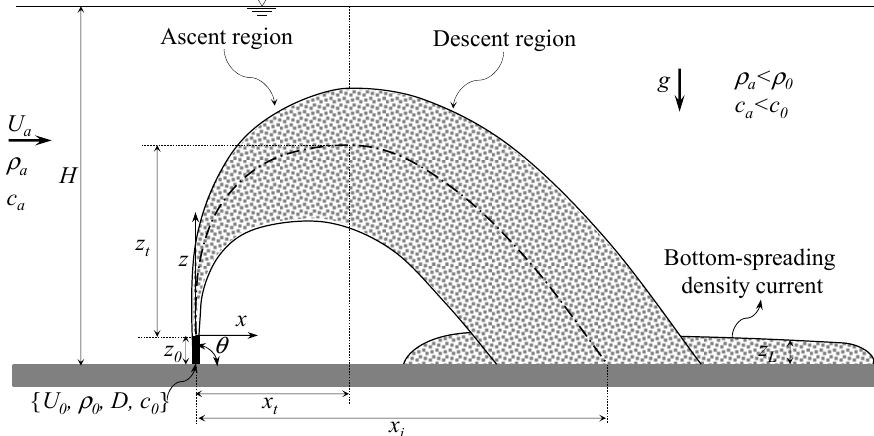
Figure 2. Definition sketch of the vertical dense jet in shallow water. The jet trajectory (jet axis or centerline) is indicated by the dashed-dot curve.